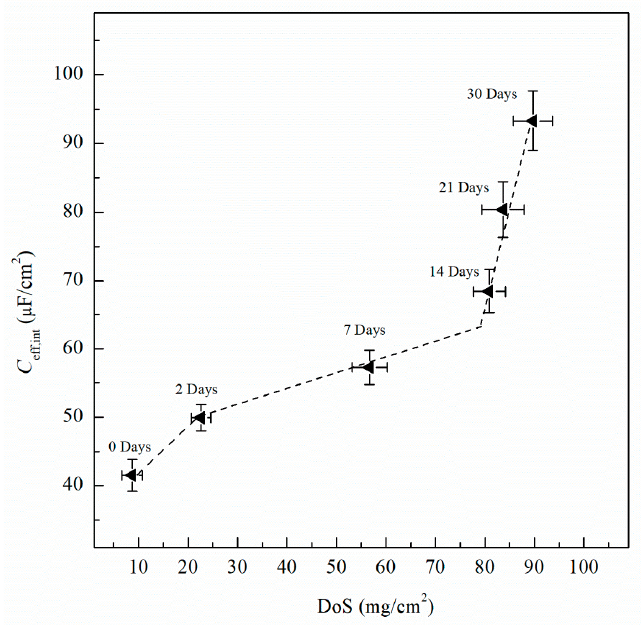
Figure 14. Effective capacitance of the intermetallics ( C eff,int ) calculated from the EIS data fitting data using Equation (3). Error bars represent standard deviation from the mean.